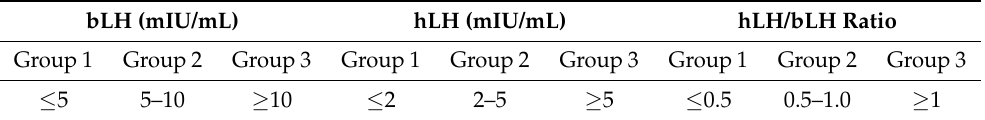
Table 1. Grouping